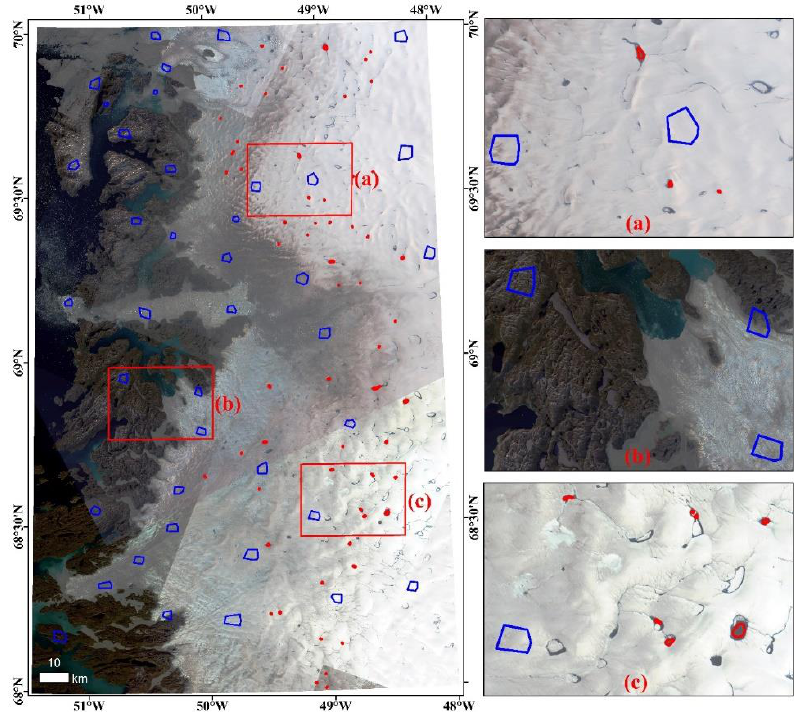
Figure 2. Manually delineated polygons within the study area. Red polygons stand for water sample, and the blue polygons stand for background sample. ( a ‒ c ) correspond to three detailed images. The background image is the same as Figure 1.